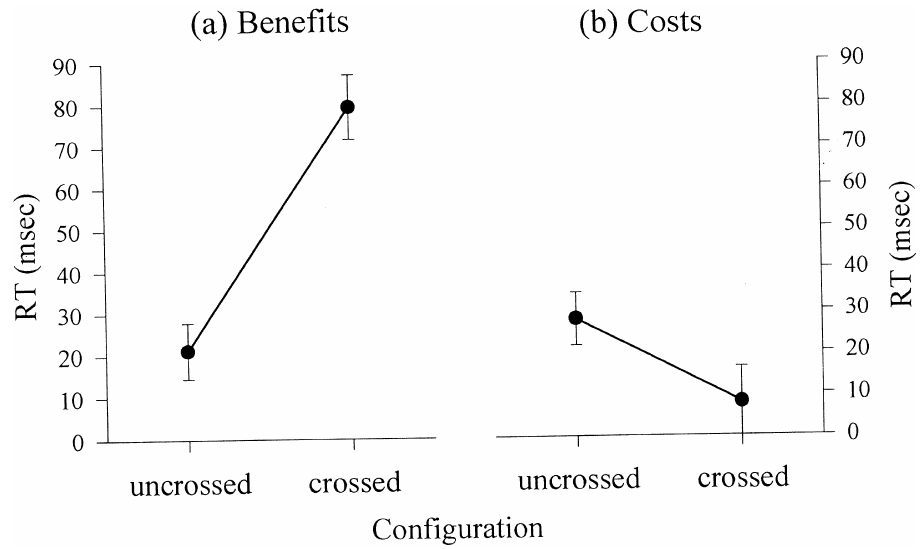
Fig. 2. (a) Benefits (msec) as a function of Configuration (uncrossed, crossed). SE bars included. (b) Costs (msec) as a function of Configuration (uncrossed, crossed). SE bars